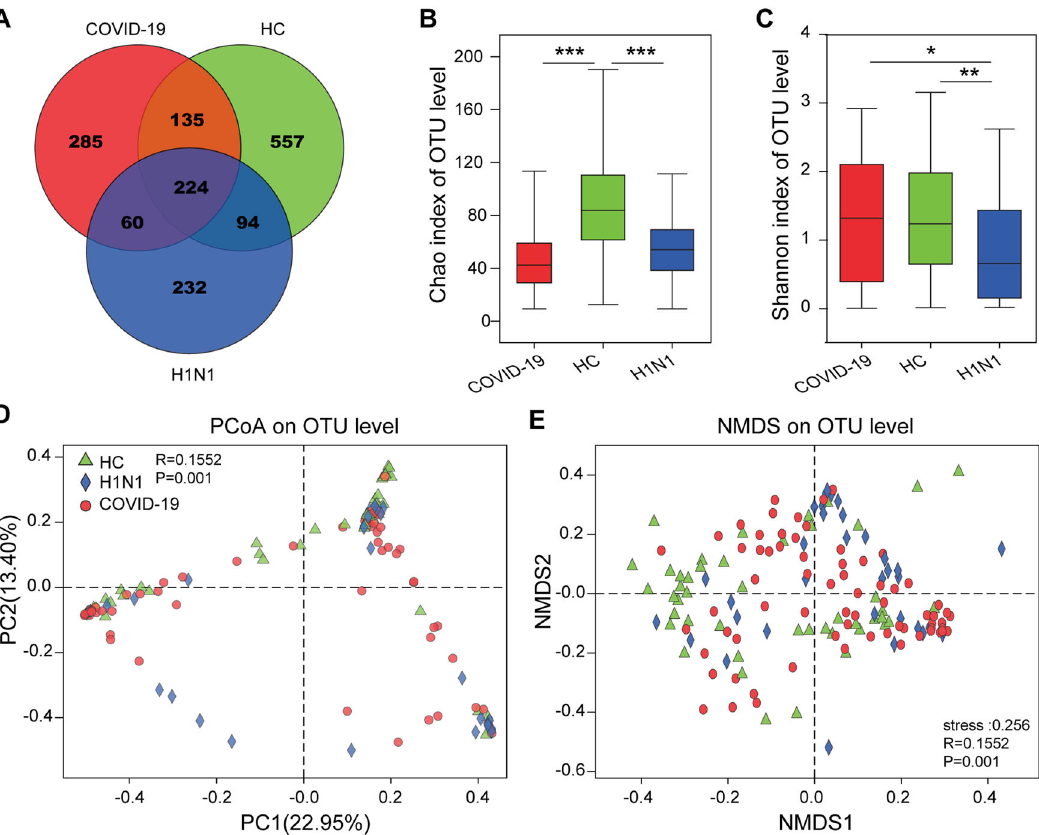
Fig. 2 Alterations in gut fungal diversity in patients with COVID-19 or H1N1 infections compared with HCs. A Venn diagram, B Chao 1 index plot, C Shannon index plot, D PCoA plot, and ( E ) NMDS plot based on the gut fungal operational taxonomic units (OTUs) of COVID-19 patients ( n = 67), H1N1- infected patients ( n = 35) and HCs ( n = 48). * P < 0.05; ** P < 0.01; and *** P <